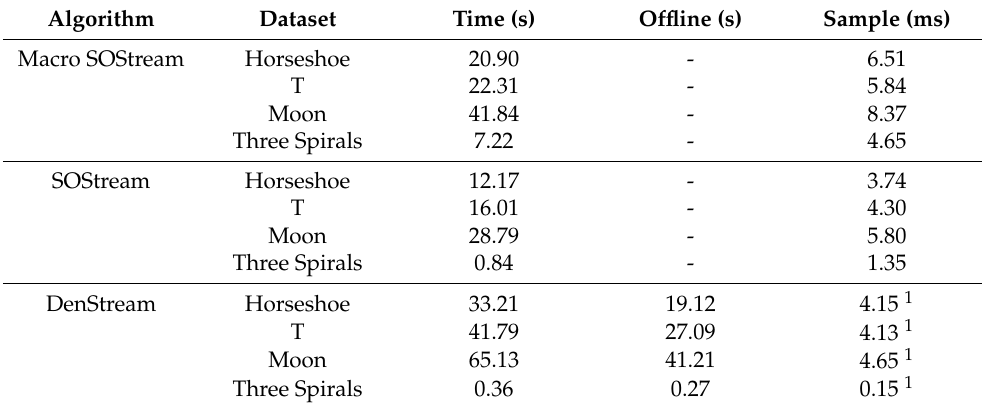
Table 5. Average processing time of evolving